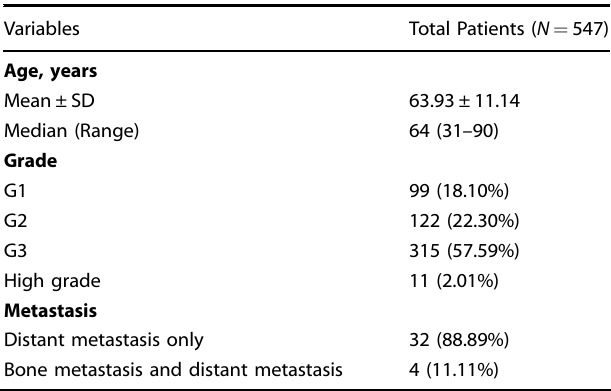
curves and scatterplots were applied to illustrate the risk score and clinical status, and red and green represent a high and low risk,